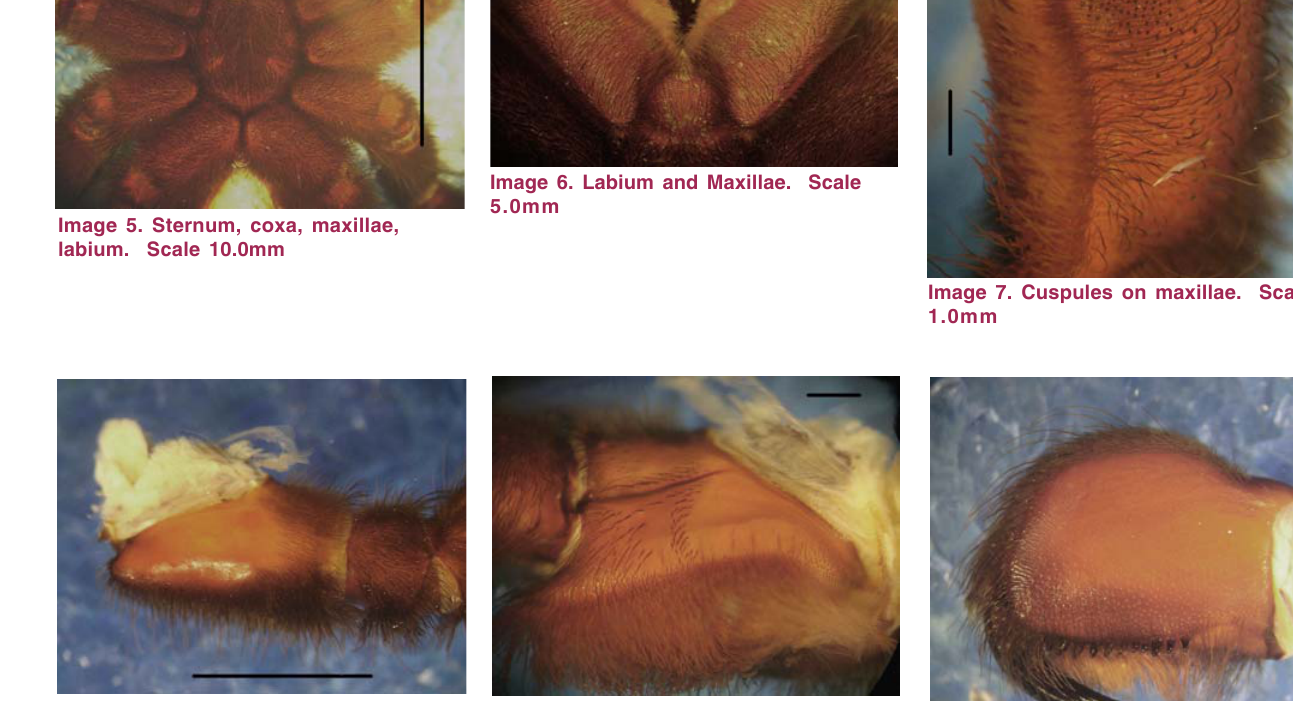
Image 9. Maxillary lyra, prolateral face. Scale